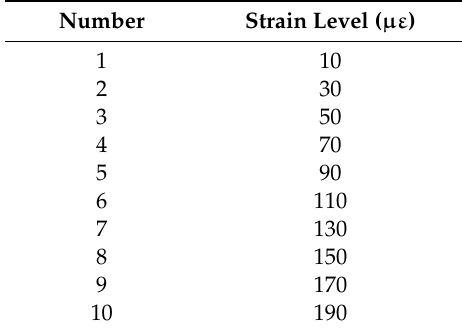
Table 1. The preselected strain levels.